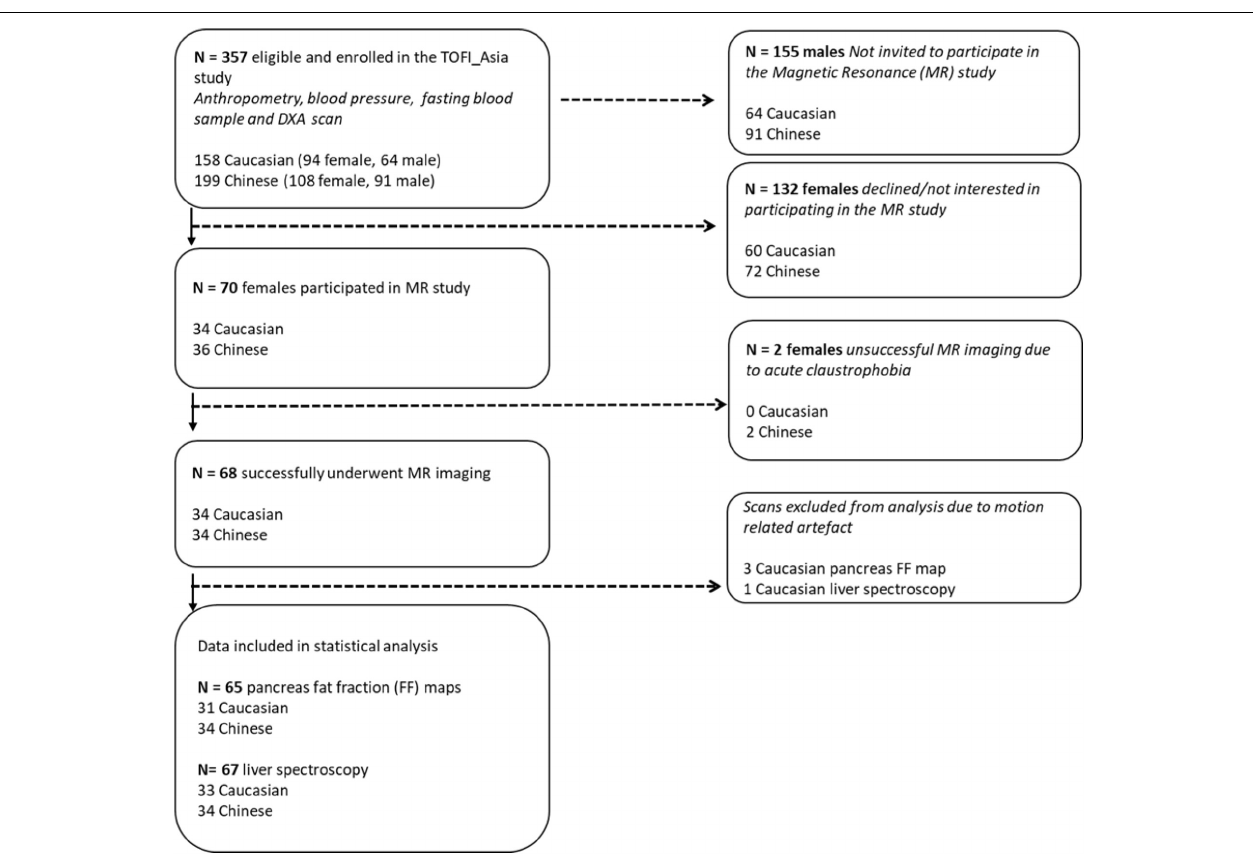
FIGURE 1 | Flowchart illustrating enrolment and eligibility of 202 female participants from the TOFI_Asia study into the MR study. DXA, dual-energy X-ray